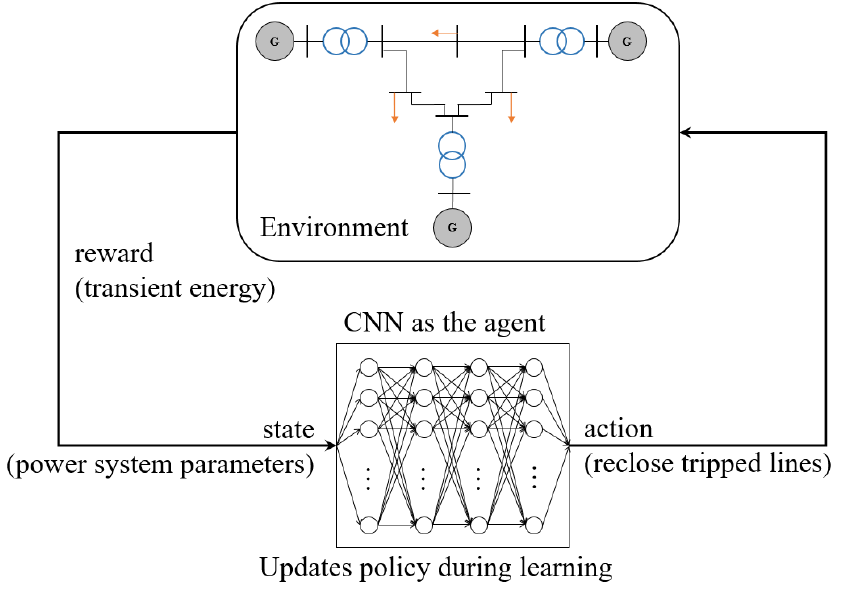
Figure 2. The schematic diagram of smart grid using DRL